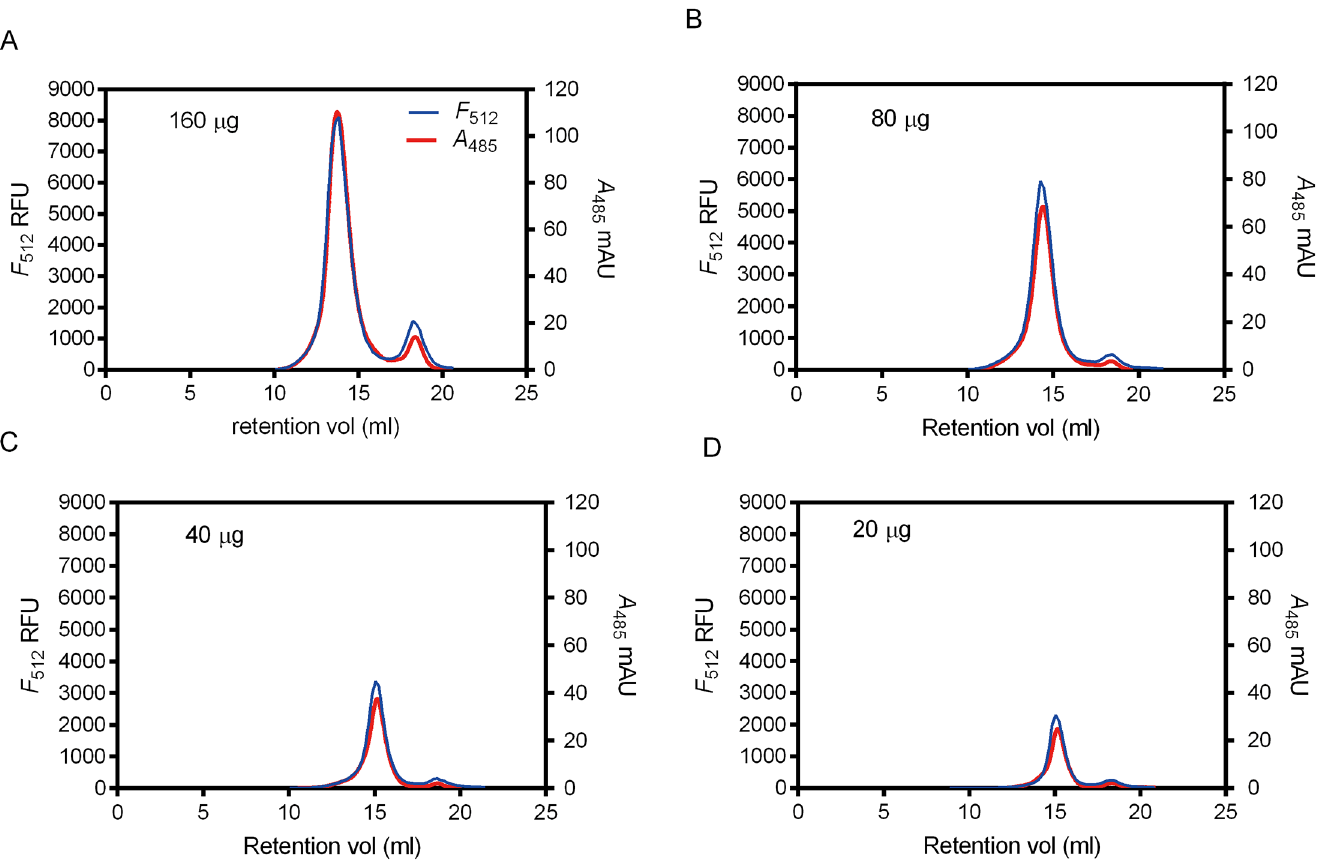
Fig 3. Comparisons of FSEC (blue trace) and FA-SEC (red trace) profiles of ASBT NM -EGFP-His8 DDM-solubilized membranes. DDM-solubilized membranes of ASBT NM -EGFP (approximately containing 160, 80, 40, and 20 μ g of ASBT NM -EGFP-His8 in A, B, C and D) were injected in Superose 6 column for profile comparison. All of the FA-SEC profiles were recorded by 10 mm path-length flow cell. The left y axis represents the F 512 intensity and the right y axis represents the A 485 intensity. The scales for fluorescence and absorption profiles in each graph are adjusted to be identical.